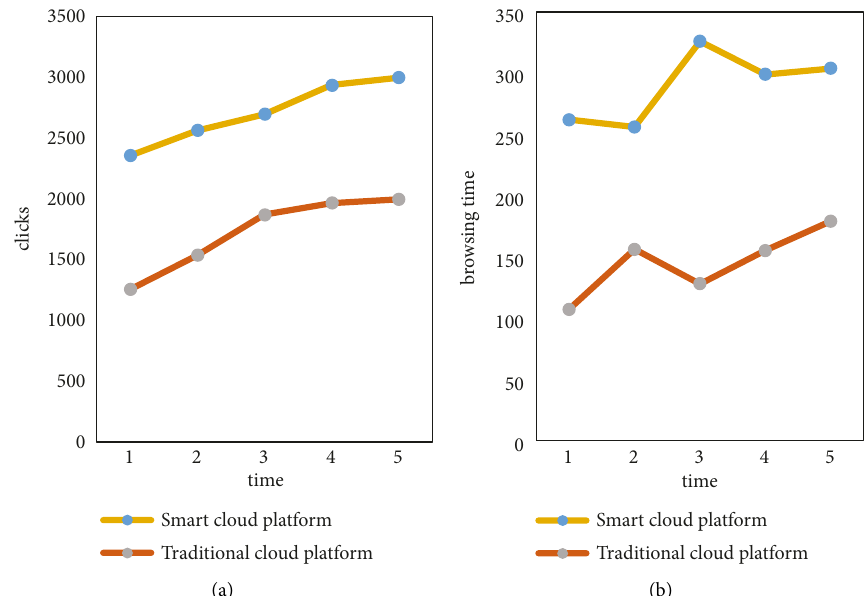
Figure 5: Comparison of clicks and browsing time of TCM cloud health platform. (a) Comparison of platform clicks. (b) Platform browsing time